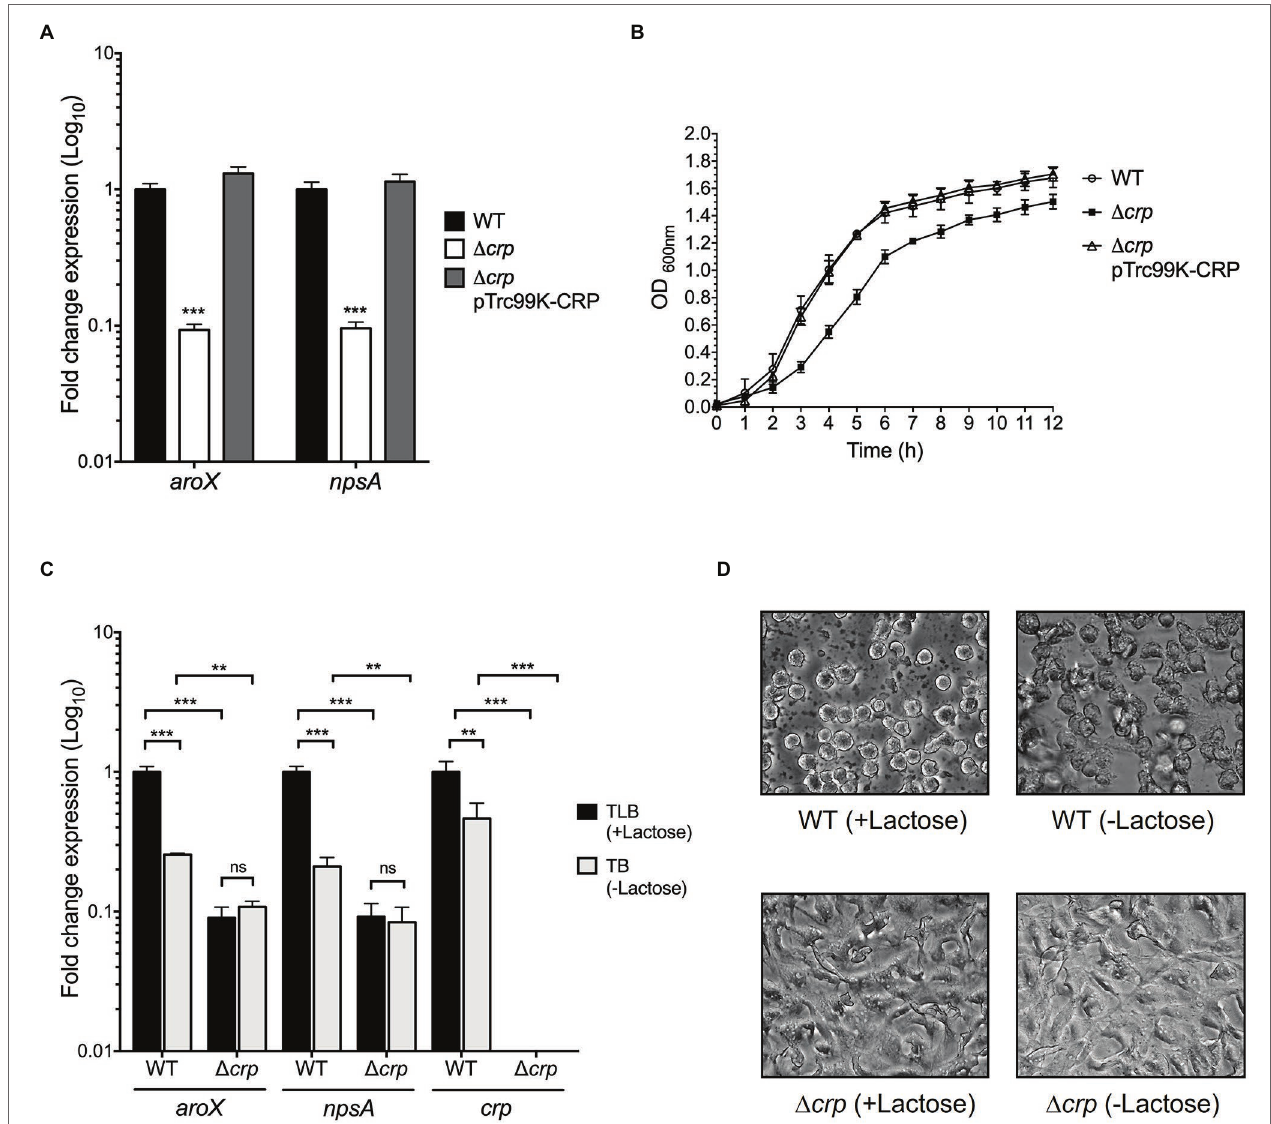
FIGURE 2 | Regulatory activity of CRP in expression of aroX and npsA genes. (A) Determination of transcriptional expression by RT-qPCR of aroX and npsA genes of wild-type K. oxytoca , Δ crp , and Δ crp pTrc99K-CRP in TLB medium at stationary phase (OD 600nm = 1.6) at 37 ° C. (B) Growth curves of wild-type K. oxytoca , Δ crp , and Δ crp pTrc99K-CRP, in TLB medium at 37 ° C. Bacterial cultures were grown for 12 h. (C) Transcription of aroX , npsA , and crp genes at stationary phase (OD 600nm = 1.6) at 37 ° C determined by RT-qPCR in TLB (medium with lactose), and TB (medium without lactose) at 37 ° C for 12 h. These graphs represent the mean of three independent experiments performed in triplicate with standard deviations. (D) HeLa cell culture inoculated with supernatants recovered from wild-type and Δ crp strains grown in TLB (medium with lactose) and TB (medium without lactose). Results represent the mean of three independent experiments performed in triplicate with standard deviations. Statistically significant with respect to wild-type strain (A) or with respect to bacteria grown in TLB medium (B): ** p < 0.01; *** p < 0.001. All Values of p were calculated using one-way ANOVA and Tukey’s comparison